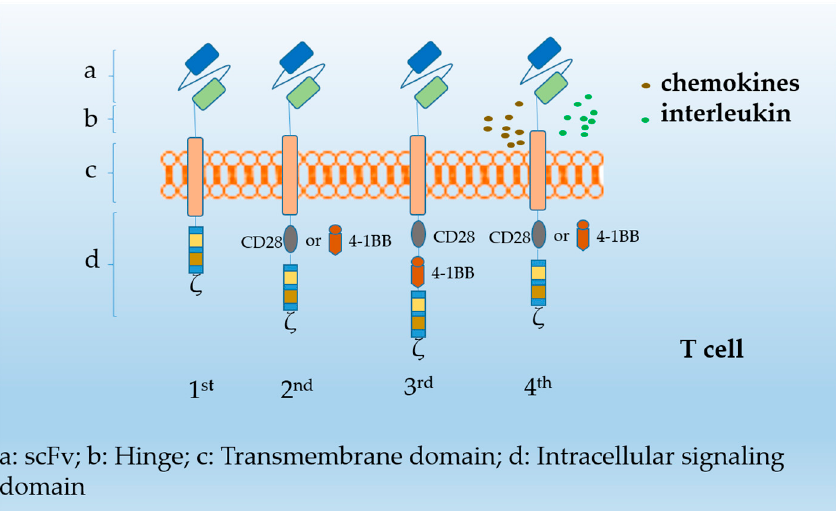
Figure 1. Molecular structure of CAR in four generations of CAR T cells. The CAR structure is em- bedded in T cells by genetic engineering and is mainly composed of a single-chain variable fragment (scFv), a transmembrane domain, a costimulatory domain (CD28 or 4-1BB), and an intracellular activation domain CD3 ζ composition. CAR T-cells utilize the specific recognition of extracellular structures and the cytotoxicity of T cells to kill target tumor cells, successfully avoiding the restric- tive effect of major histocompatibility complex (MHC) class I and improving the lethality of tumor cells. The first-generation CAR T-cell scFv couples with intracellular CD3 ζ to obtain specific antigen recognition ability, and the second-generation CAR T-cells add the CD28 or 4-1BB costimulatory domain structure to overcome the persistent poor activation of T cells, low activation intensity, and cytokine secretion disorder. The third-generation CAR T-cells that combine both CD28 and 4-1BB costimulatory domains have improved cytotoxicity and persistence, while fourth-generation CAR T-cells with one costimulatory domain are genetically engineered to introduce specific genes to perform cytotoxic functions and maintain T cell